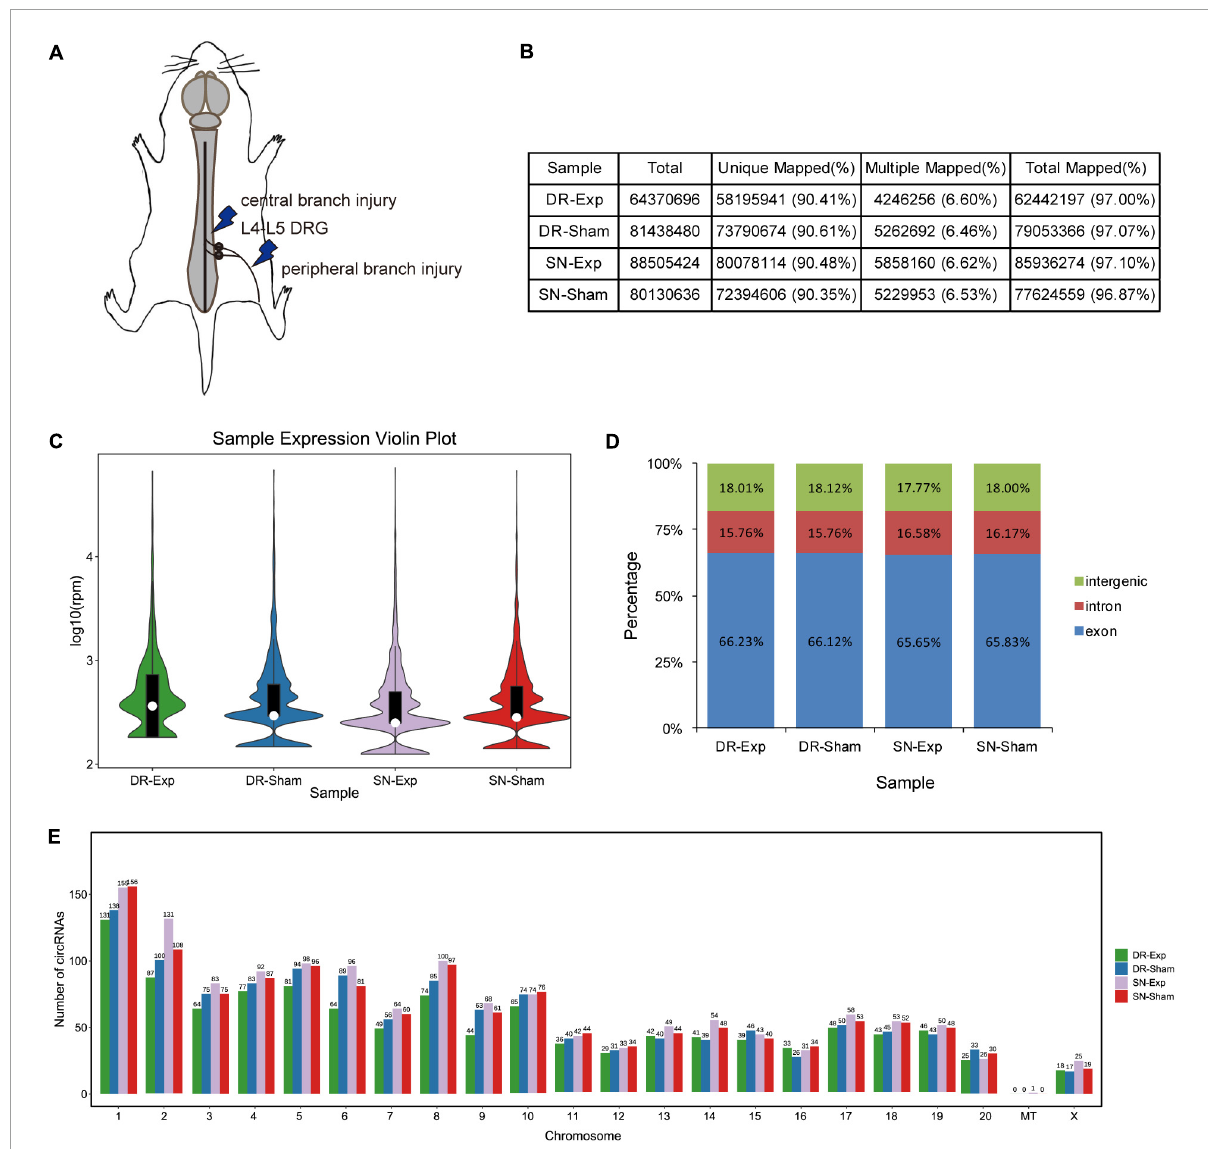
FIGURE1 Characterization of circular RNAs in dorsal root ganglions (DRGs). (A) Schematic representation of nerve injury model. (B) The alignment of sequencing reads to the reference genome in rats underwent central injury, peripheral injury, or corresponding sham surgery. (C) The violin plot of the abundances of circular RNAs. (D) Genomic origins of circular RNAs. (E) Numbers of circular RNAs in each